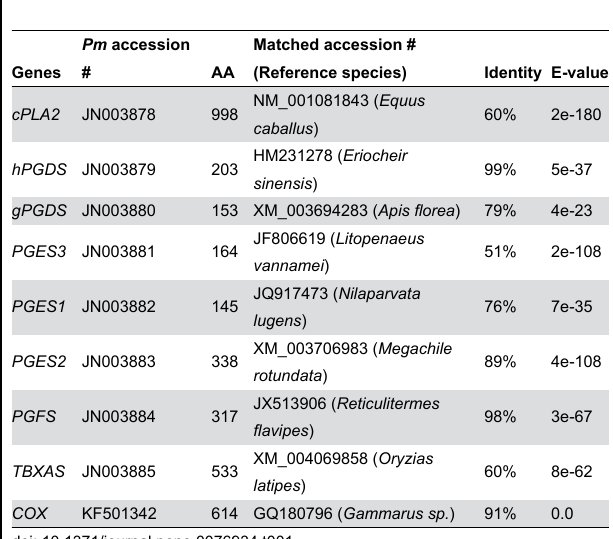
Table 1. TBLASTX analyses of P. monodon prostanoid biosynthesis